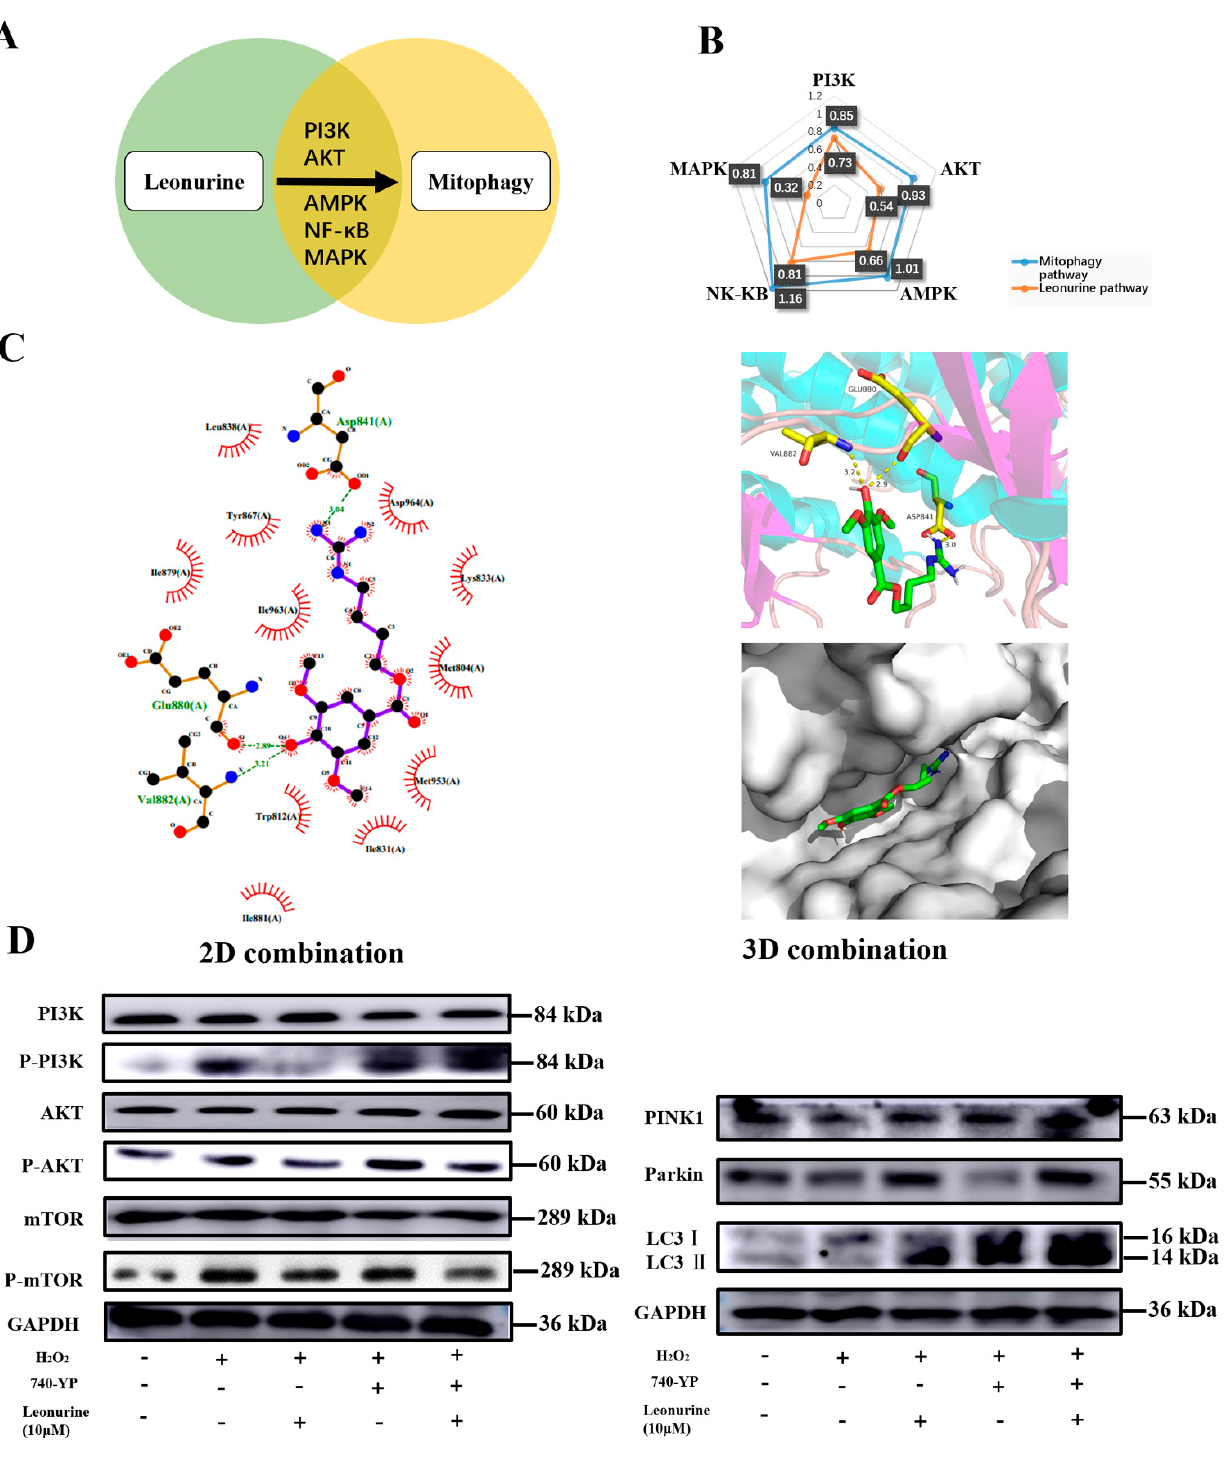
Figure 6. Leonurine can directly moderate PI3K-AKT-mTOR activation. ( A ) Research on the analysis of the leonurine and mitophagy pathway. ( B ) Relevance score on the analysis of the leonurine and mitophagy pathway. ( C ) 2D-molecular docking and 3D-molecular docking between leonurine and the PI3K protein. ( D ) The effect of leonurine on the PI3K-AKT-mTOR pathway and change in mitophagy.